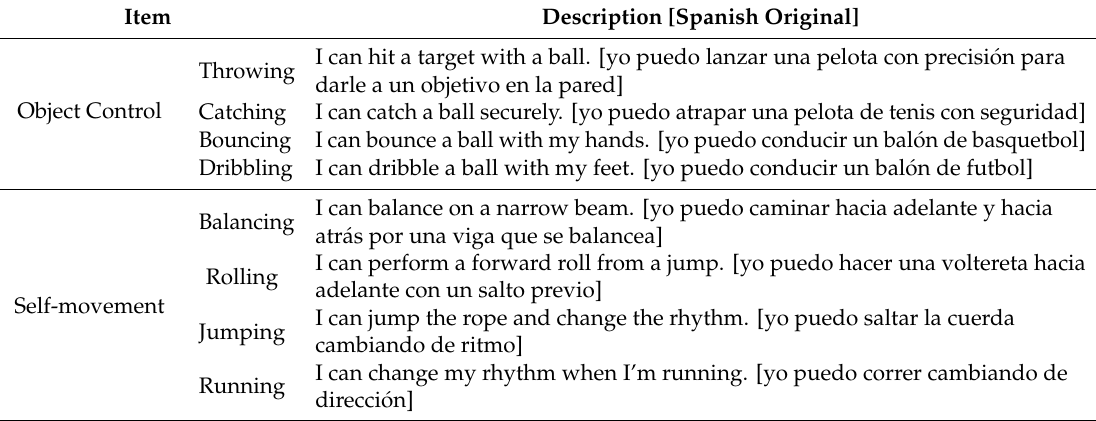
Description of the Selbstwahrnehmung Motorischer Kompetenzen (SEMOK) questionnaire